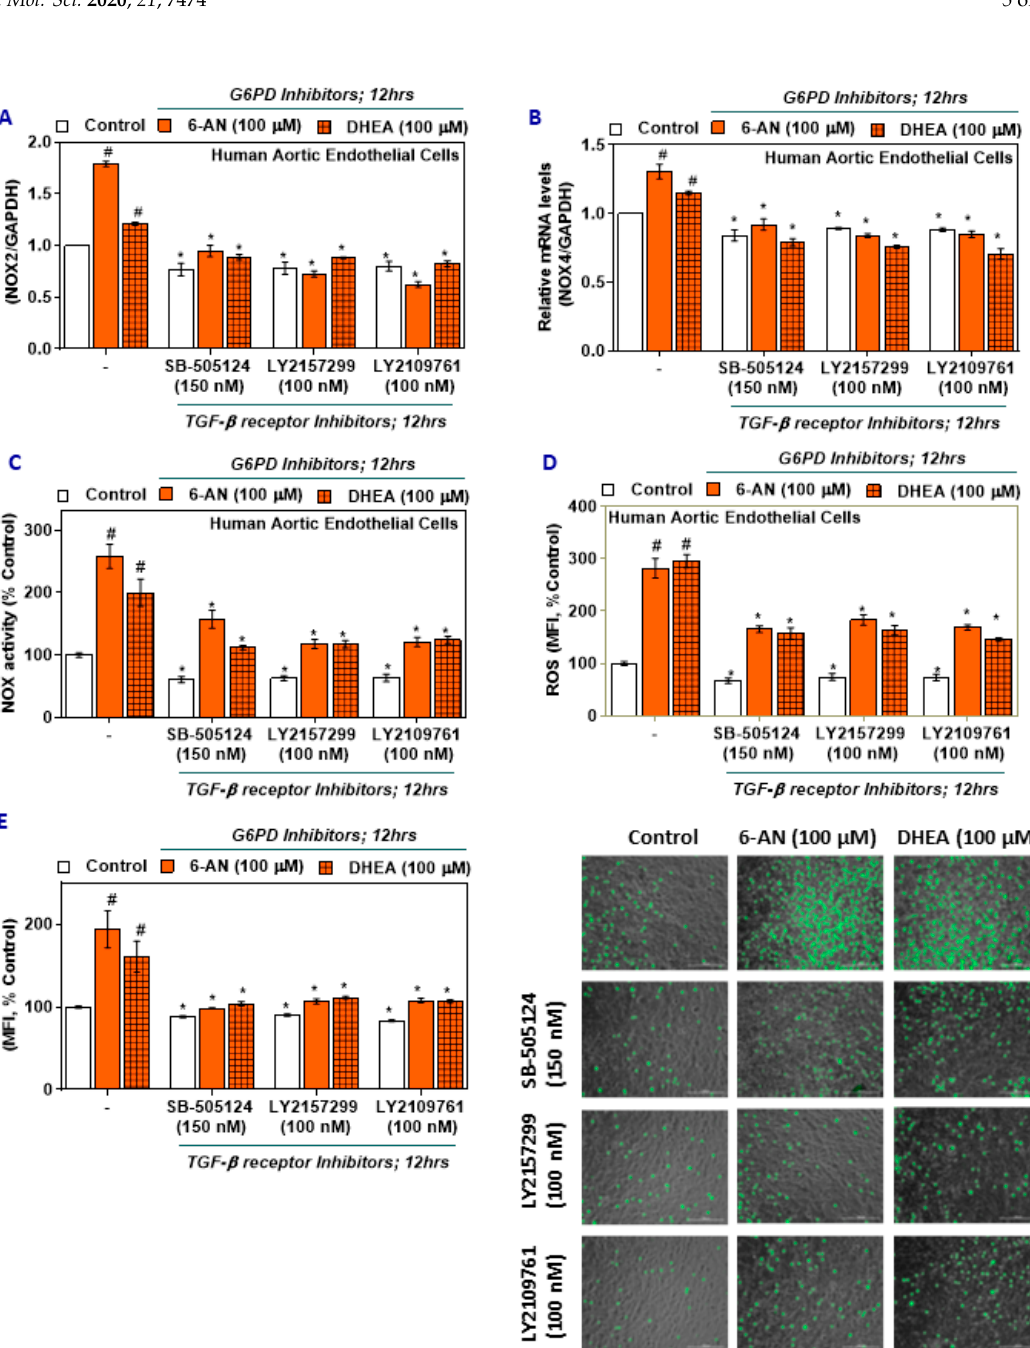
Figure 3. The effect of G6PD and TGF- β receptor pharmacological inhibitors on NOX2 and NOX4 expression, NADPH oxidase activity, ROS in HAEC, and monocyte-endothelial cell adhesion. ( A , B ) NOX2 and NOX4 mRNA. ( C ) NADPH oxidase activity. ( D ) ROS. ( E ) Phase-contrast images of HAEC and SC monocytic cells (scale bar: 200 µ m). Results are mean ± SEM ( n = 3–6). Significance at p < 0.05: #, compared with control–G6PD inhibitor alone groups; *, compared with control–TGF- β receptor inhibitor groups.